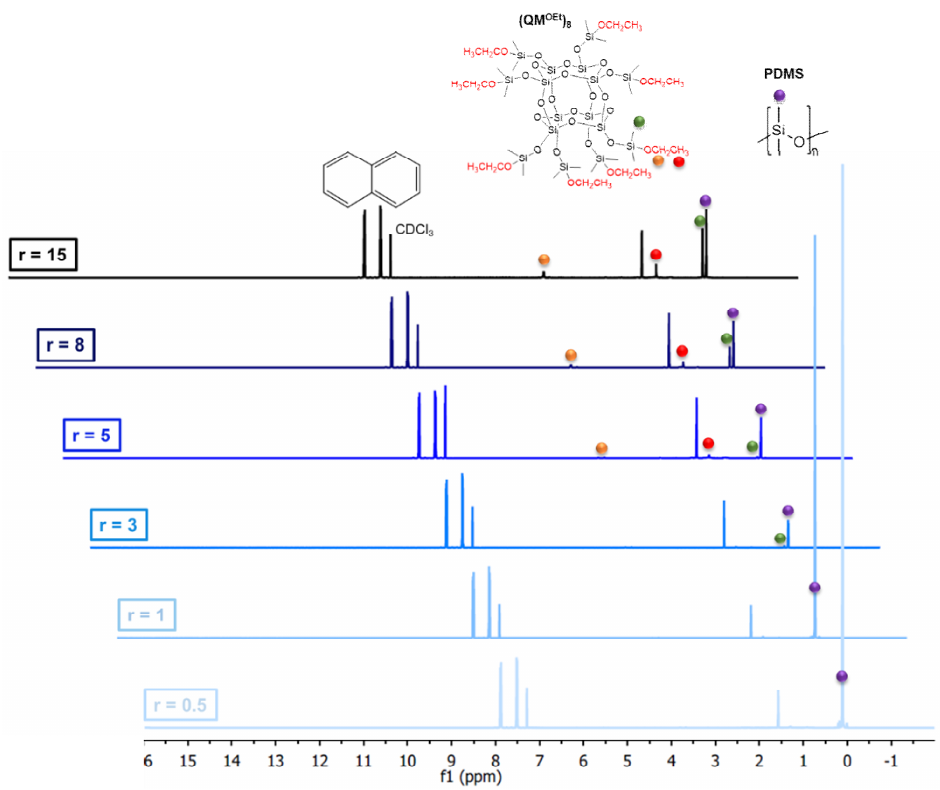
Molecules 2021 , 25 , x FOR PEER REVIEW Figure 6. 1 H-NMR spectra of extracts from 1-day old elastomer films prepared via the reaction between C2T and (QM OEt ) 8 . The stoichiometric ratio was varied from 0.5 to 15.